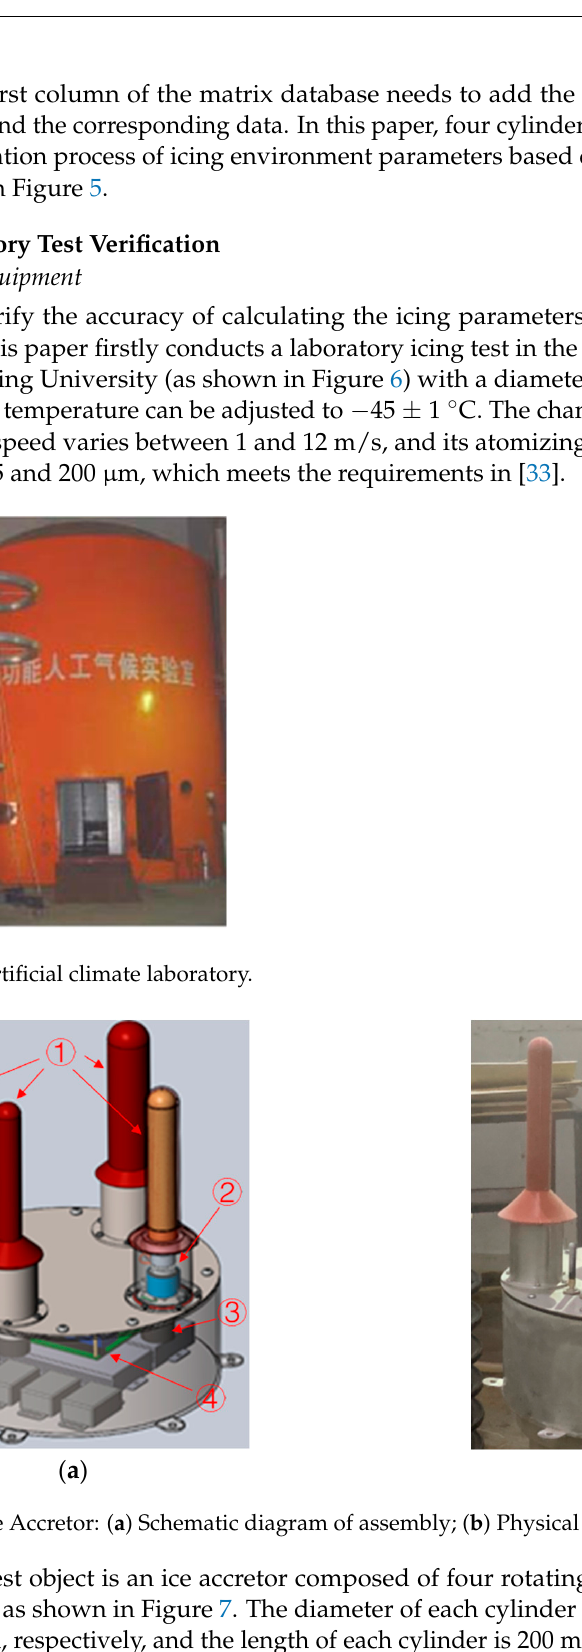
( b ) Figure 7. Ice Accretor: ( a ) Schematic diagram of assembly; ( b ) Physical structure.